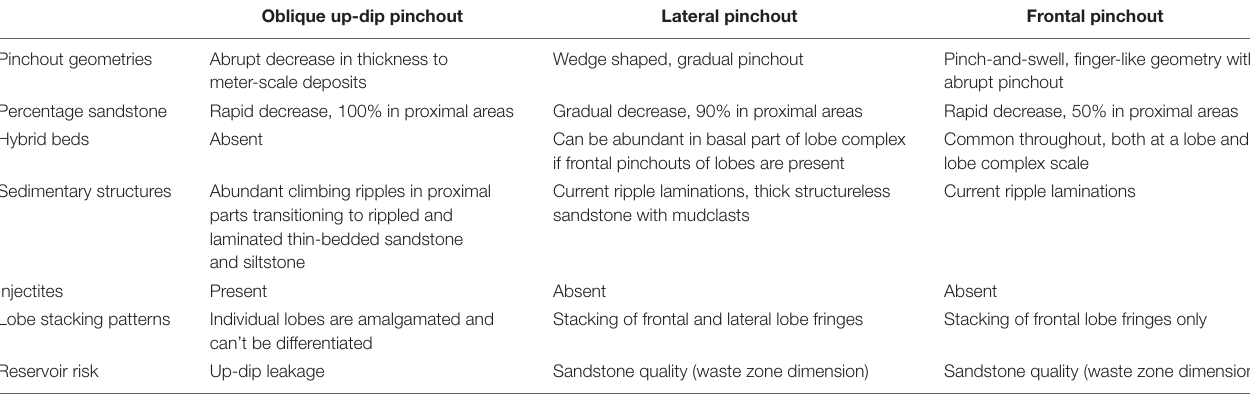
TABLE 2 | Characteristics of oblique up-dip, lateral and frontal lobe pinchouts. Oblique up-dip